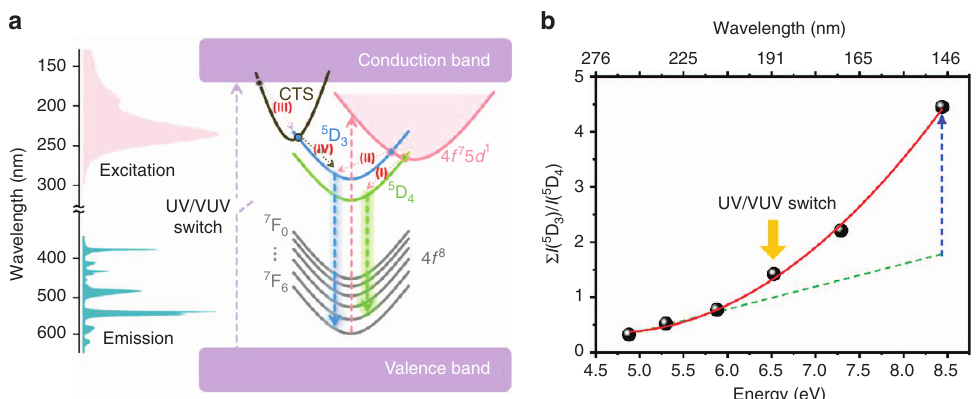
Figure 3 Mechanism. ( a ) Con fi gurational coordinate model of the color-reversal effect. The broken arrow from VB to CB represents a color switch that is tunable and reversible between green and blue emissions. ( b ) Ratio of the blue set to the green set, Σ I ( 5 D 3 )/ I ( 5 D 4 ), under 254 nm UV to 147 nm VUV excitation. The ratio of the entirely integrated emission bands of 5 D 3 → 7 F J = 3 – 6 to that of 5 D 4 → 7 F J = 3 – 6